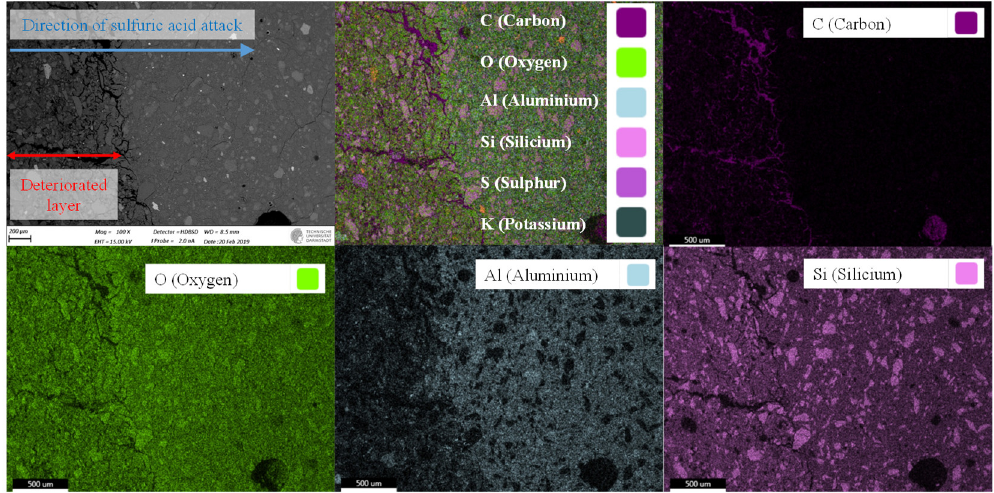
Figure 7. SEM-EDX elemental mapping of epoxy resin embedded cross-section of Geopolymer MK54 after exposure to sulfuric acid, showing high porosity within the deteriorated layer as well as varying element composition due to sulfuric acid attack.